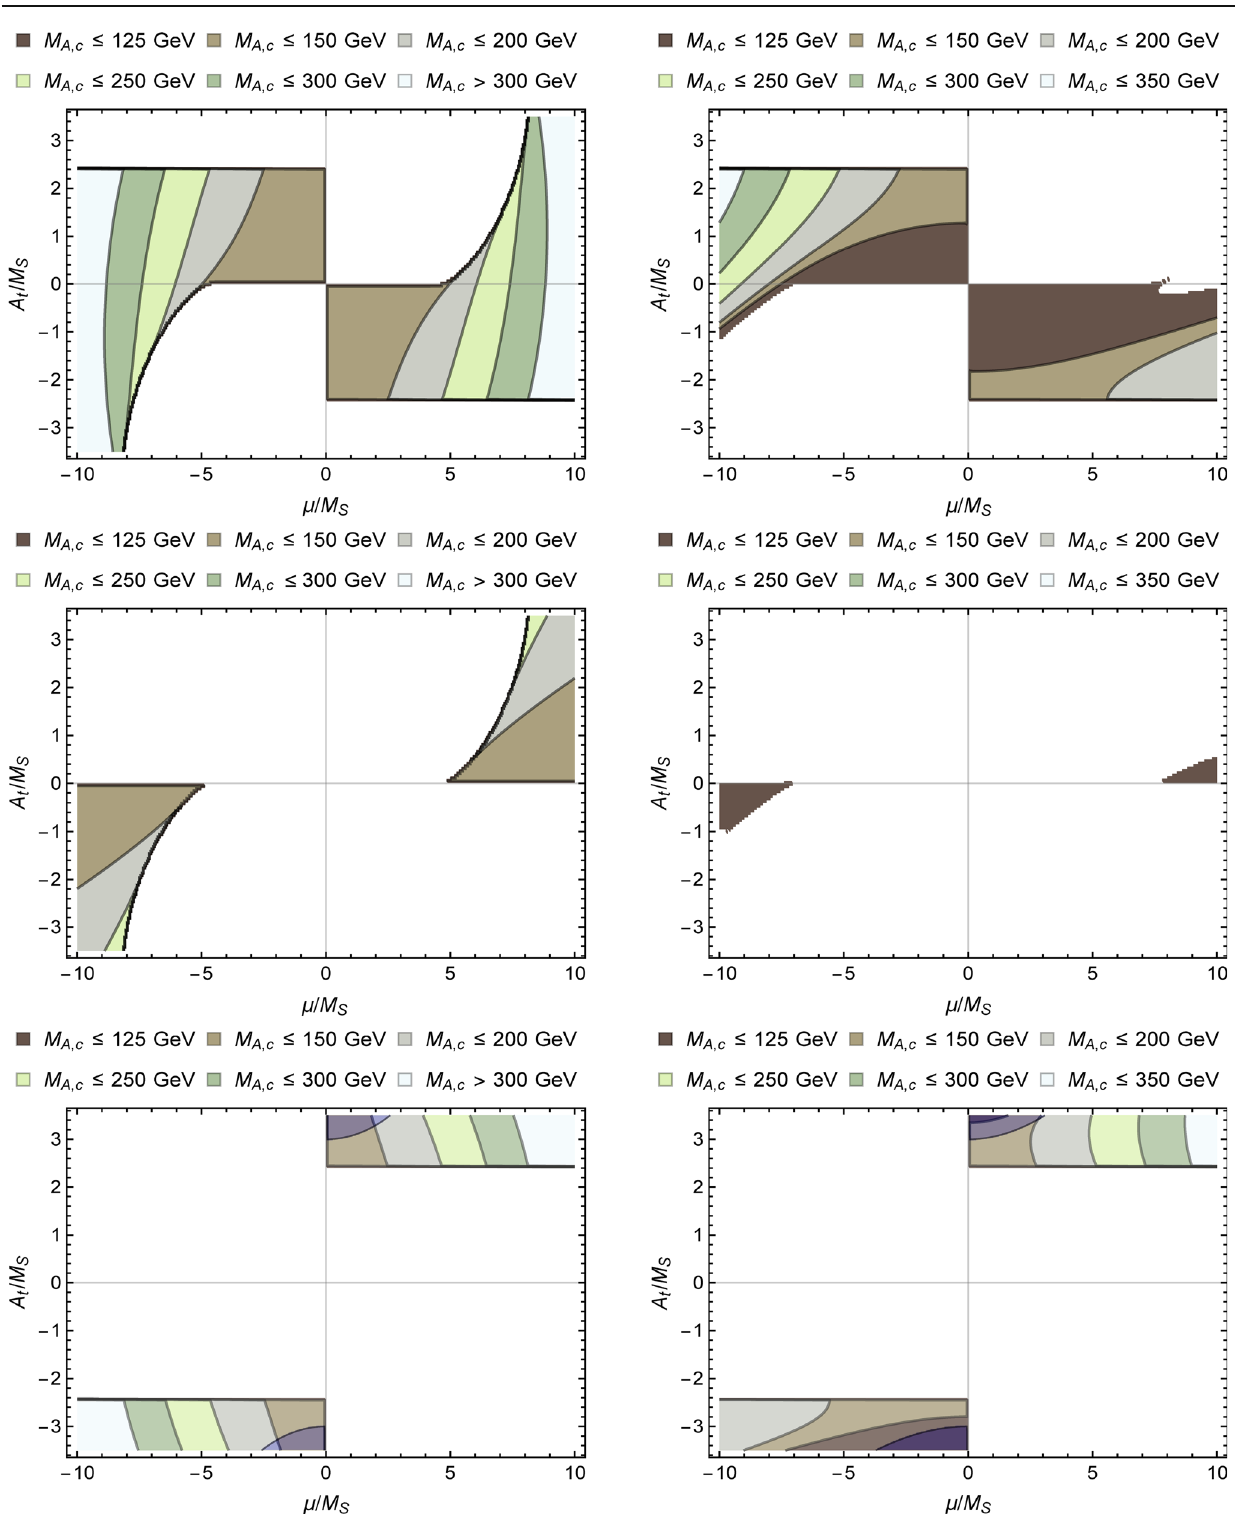
Fig. 5 Critical M A value, M A , c , in the exact alignment, indicating the maximal M A value for which the mass hierarchy of the heavy Higgs interpretation is obtained, corresponding to the solutions found in Fig. 3